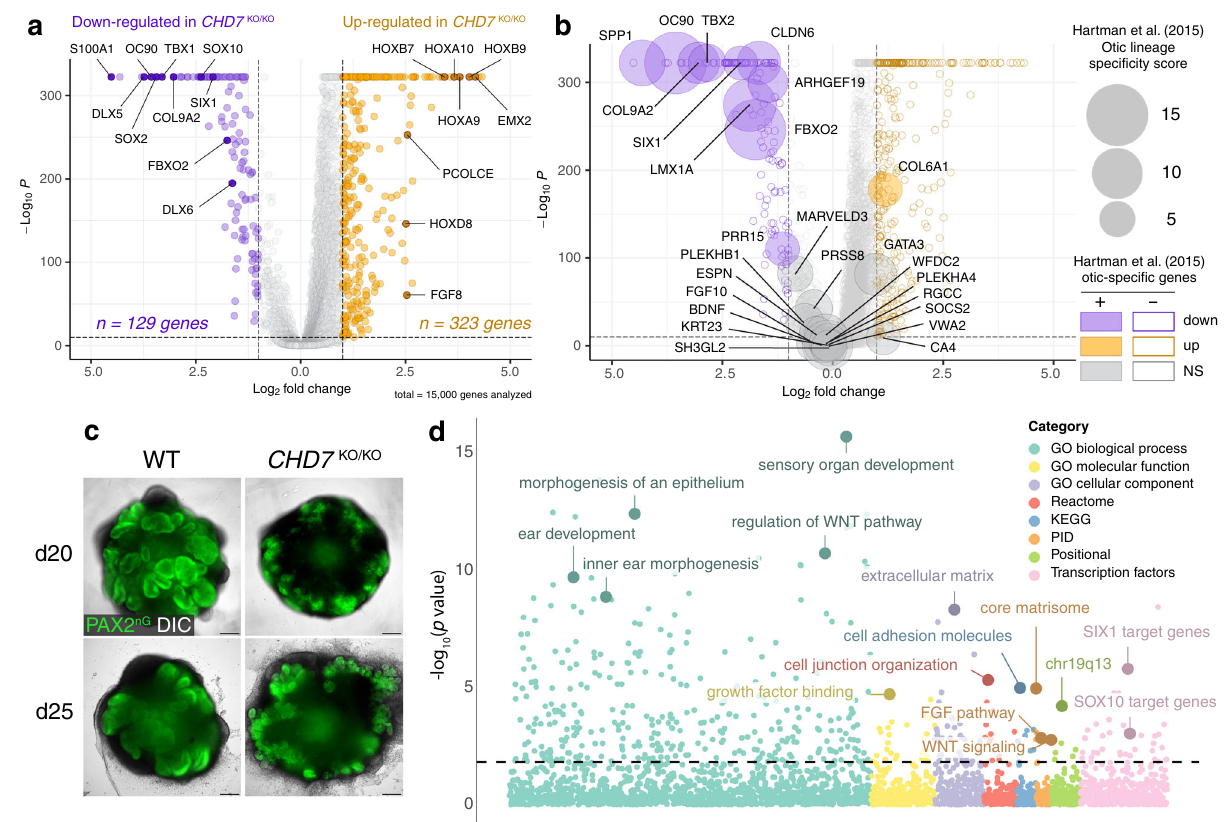
Fig. 4 | scRNA-seq of d20 WT and CHD7 KO/KO organoids suggest CHD7 plays essential role in otic development. a Volcano plot of differentially expressed genes in CHD7 KO/KO otic progenitors. b Bubble plot of dysregulated and unaffected otic lineage-speci fi c genes in CHD7 KO/KO otic progenitors. The areas of the bubbles representthegene expressionfold-change values ofE10.5oticvesiclesversusnon- otic tissues asreported by Hartmanet al. (2015) c Live imaging of d20 and d25 WT and CHD7 KO/KO organoids. d Bubbleplotof enriched genesetsfromdownregulated